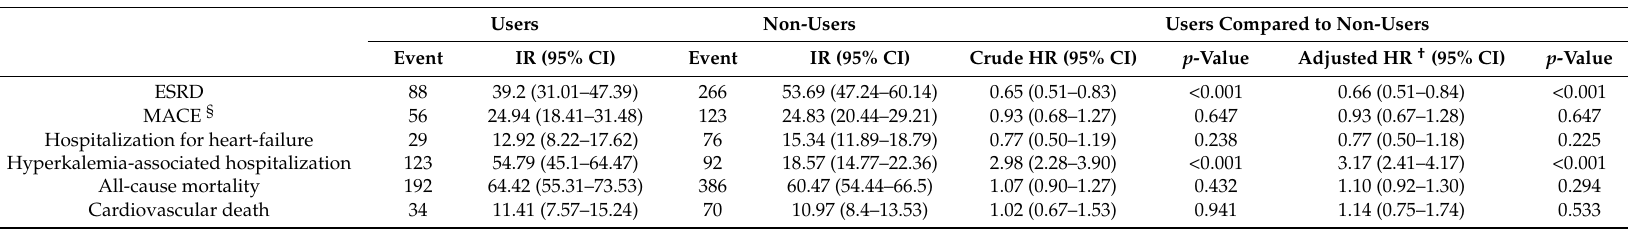
Table 2. RisksforESRD,MACEs, hospitalizationforheart-failure,